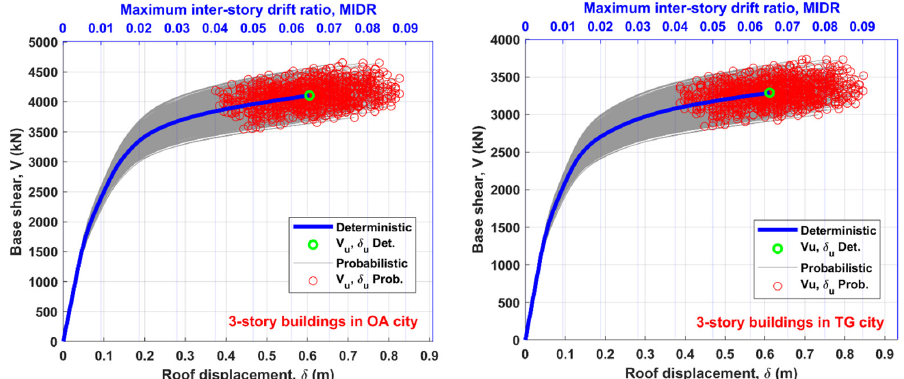
Figure 3. Deterministic and probabilistic capacity curves of the 3-story buildings in OA and TG cities.